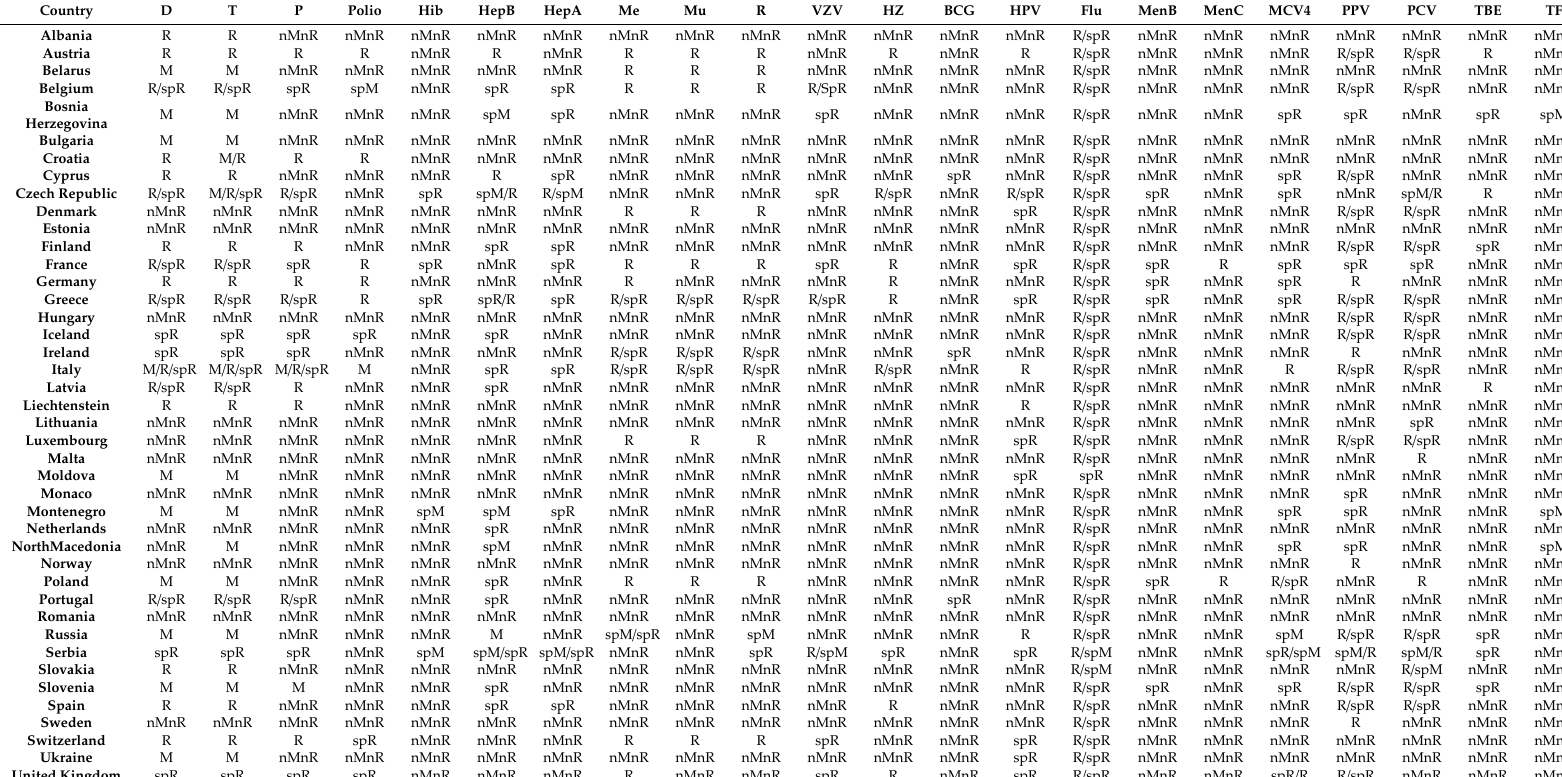
Table 2. National vaccination policies for adults in Europe by vaccine and by country,